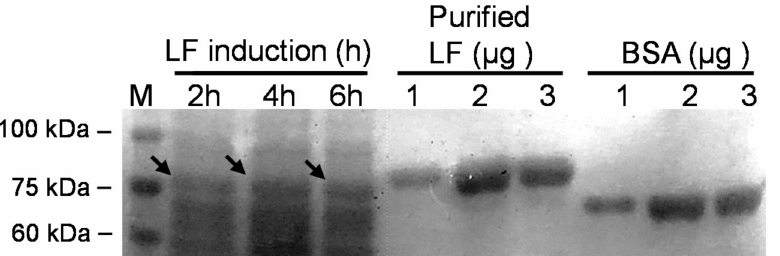
Figure 6. SDS-PAGE profile of recombinant BLF expressed by Lactobacillus gasseri . Time course of expression of recombinant BLF from L. gasseri /BLF cell extracts prepared from samples collected after 2, 4, and 6 h of induction using nisin. Cell lysates were harvested and subjected to SDS-PAGE analysis. Three purified LF and bovine serum albumin standards (1, 2, and 3 µ g) were used to evaluate the level of recombinant LF expression in probiotic host. M: molecular weight marker; arrow indicates target lactoferrin with a molecular weight of around 80